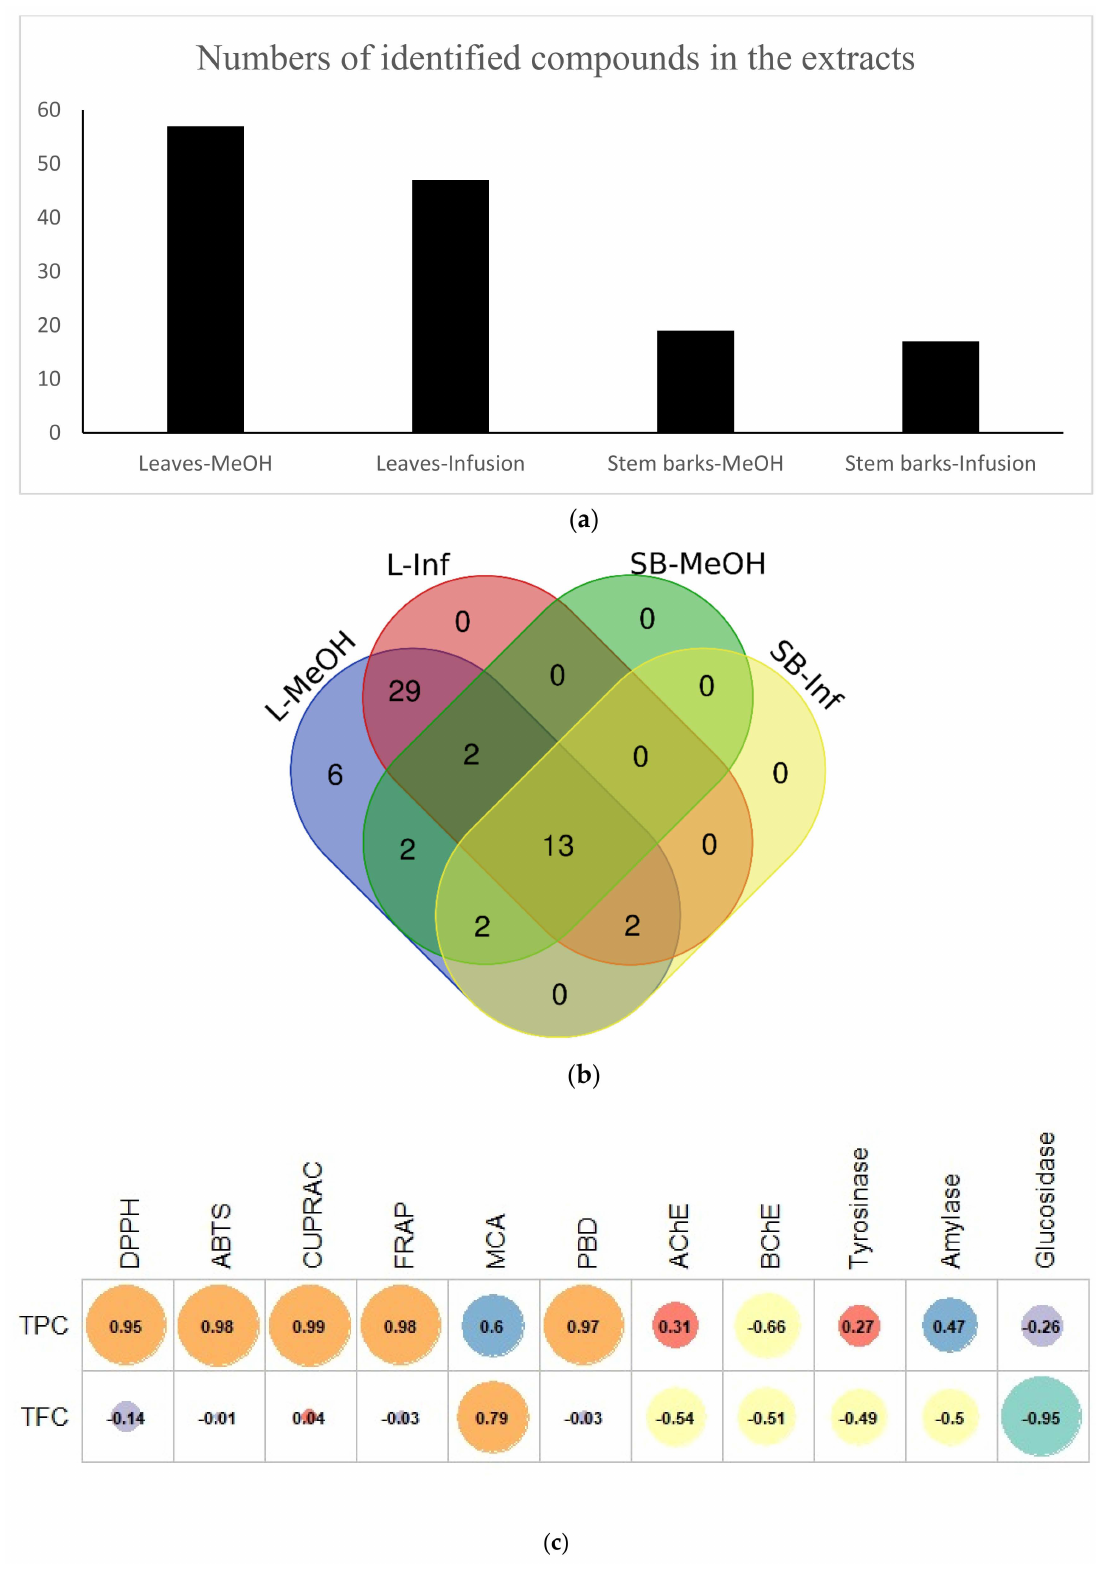
Figure 2. ( a ) Number of identified compounds in the extracts. ( b ) Venn diagram showing the number of common compounds found in the tested extracts. L-MeOH—leaves-MeOH; L-Inf—leaves-infusion; SB-MeOH—stem bark-MeOH; SB-Inf—stem bark-infusion. ( c ) Pearson’s correlation between total bioactive components and antioxidant and enzyme inhibitory